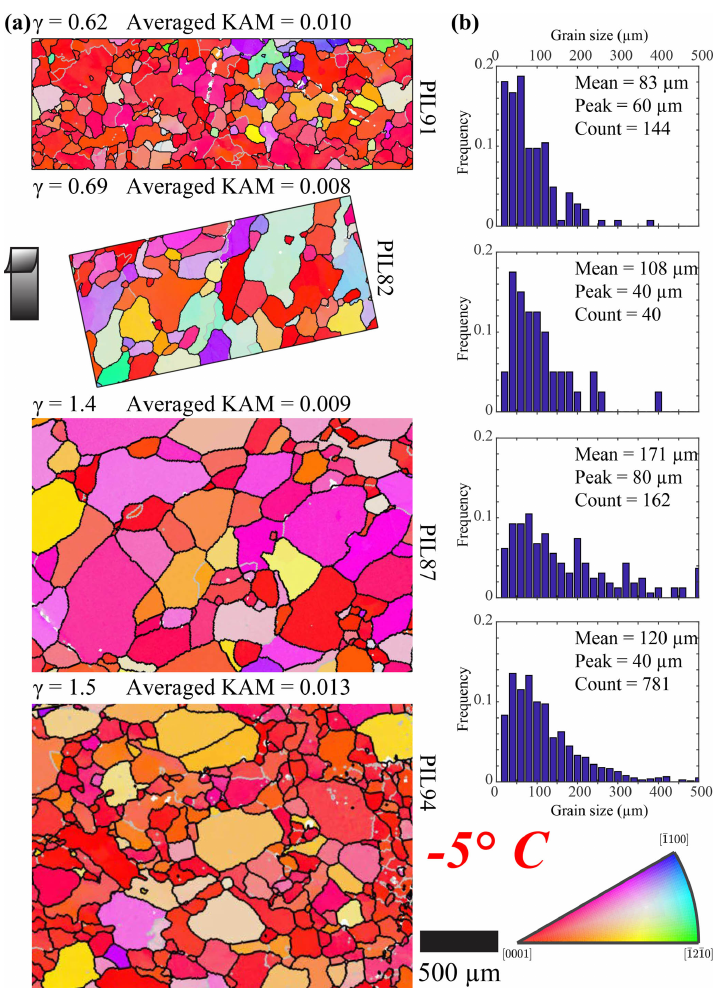
Figure 5. Microstructure of the shear planes of samples deformed at − 5 ◦ . Strain increases from top to bottom. (a) Orientation maps colored by the crystallographic orientation normal to the shear surface according to the color map at bottom right. Step size is between 5 and 7µm (see Table 2, columns 5–7). Grain boundaries, characterized by a misorientation of 10 ◦ , are black, and subgrain boundaries, characterized by a misorientation of 2 ◦ , are gray. Un-indexed spots are white. The shear direction on the top side is up, as shown by the black arrow. Maps are subareas of the whole mapped area (except for PIL91 and PIL82). The whole mapped area was used to calculate KAM and grain size. (b) Distributions of grain